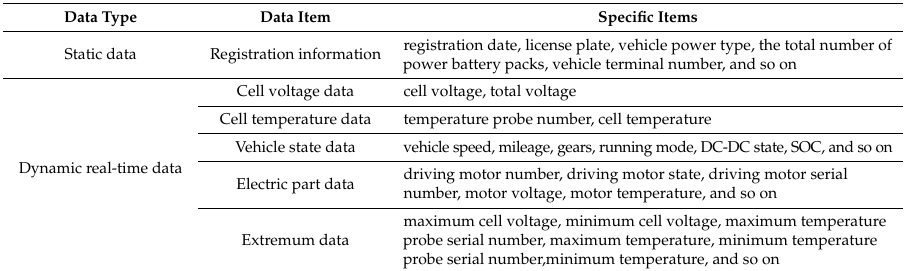
Table 1. National standard information collection items. DC: Direct Current; SOC: state of